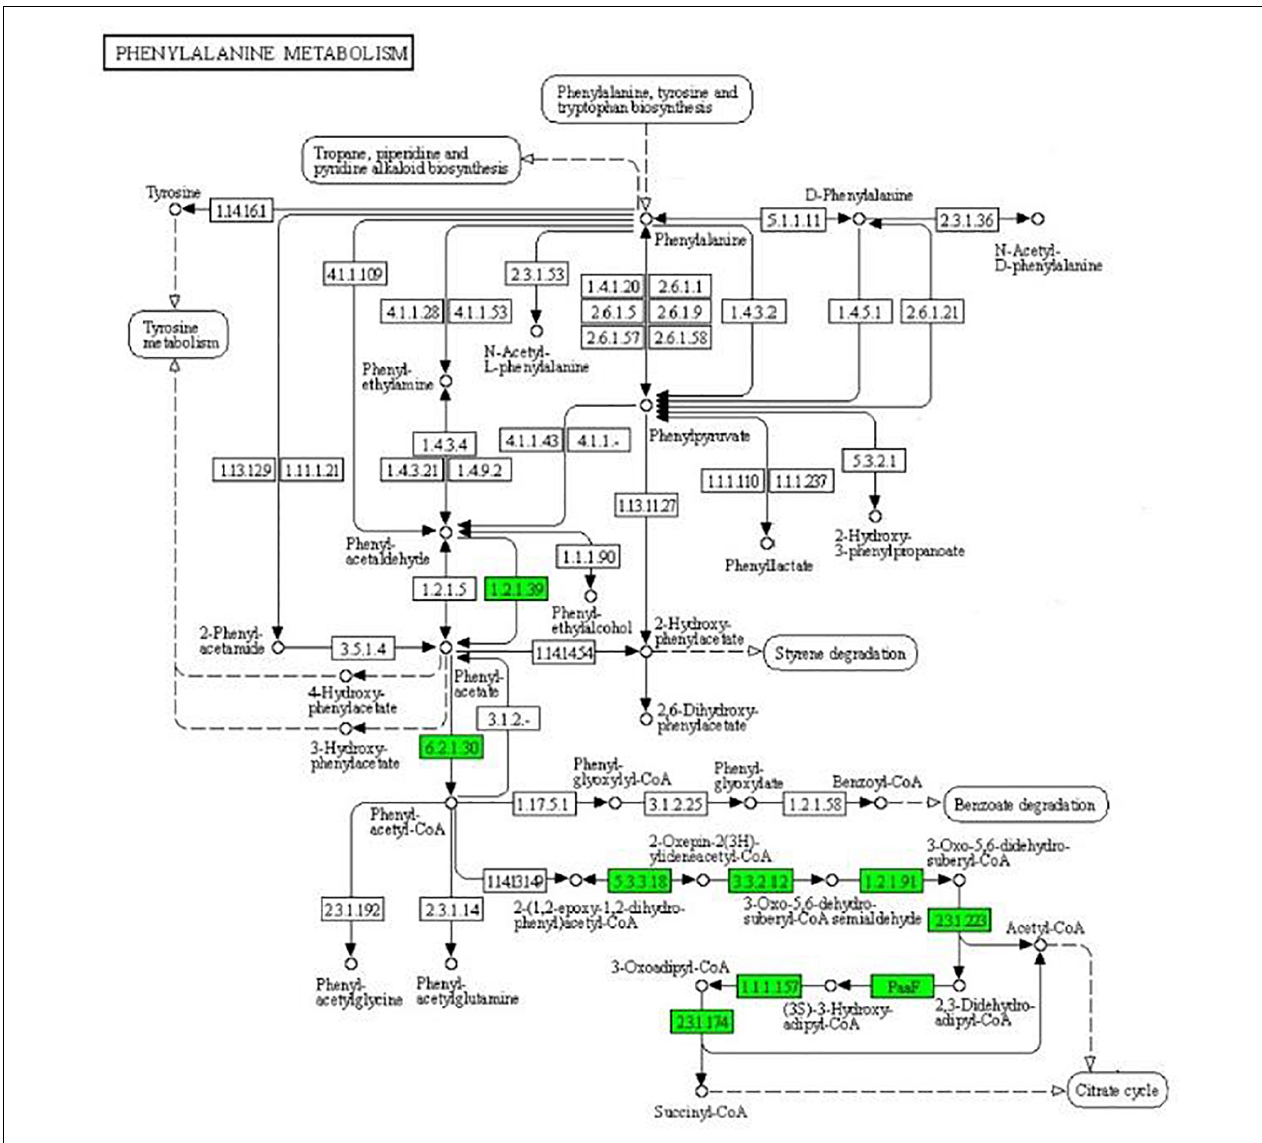
FIGURE 5 | Significantly enriched KEGG pathway: Phenylalanine metabolism (from the KEGG database, green frames represent downregulation, and red frames represent upregulation).